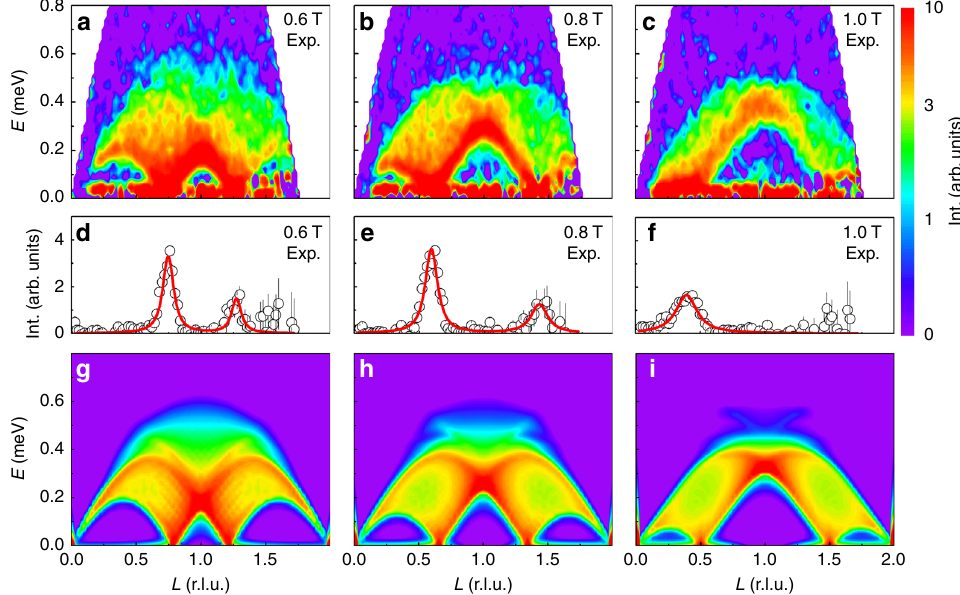
Fig. 4 Magnetic fi eld tuned spin excitation of YbAlO 3 . a – c Inelastic neutron scattering spectra with background corrected measured at 0.05 K, in different magnetic fi elds applied along the a -axis, of 0.6 T ( a ), 0.8 T ( b ), and 1.0 T ( c ). d – f The Q -cuts of in- fi eld experimental data along wave vector (00 L ), integrated over H = [ − 0.1; 0.1] r.l.u., K = [ − 0.6; 0.2] r.l.u., and E = [0.05; 0.06] meV. The peak positions indicate the zero energy soft modes, where the gap closes. In the raw data, the error bar is equal to the square root of the number of counts (Poisson statistics). In the processed data, where we have various ef fi ciency corrections and we need to account for different measurement statistics at each point, we used the rules for propagation of errors of uncorrelated measurements. g – i DMRG simulated spin excitation spectrum, with staggered fi eld B st = 0, and external fi eld B ex / J = 0.8 ( g ), B ex / J = 1.2 ( h ), and B ex / J = 1.6 ( i )